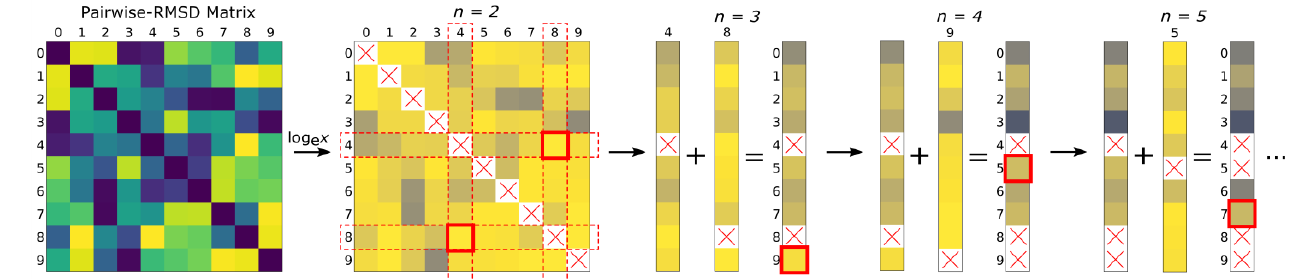
Figure 2. Illustration of the similarity downselection algorithm. The natural log is taken on a square matrix containing the pairwise-similarity relations of the items in the full population. The two most dissimilar items (i.e., most dissimilar subset n = 2 ) are found and their arrays summed to find the third most dissimilar item (i.e., subset n = 3). Successive most dissimilar subsets are iteratively found by adding the array of the most recently found item to the summation array and taking the index of the largest (or smallest) value. Items already selected cannot be selected again and are represented as nan in the summation array.